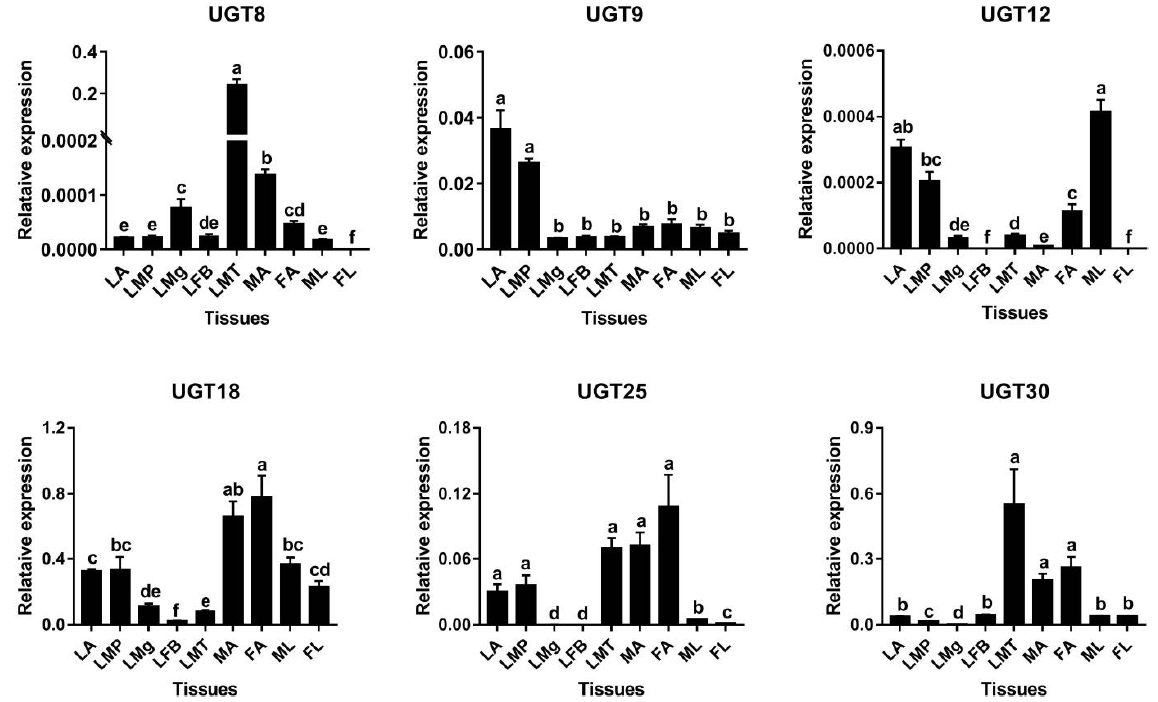
Figure 4. qPCR analysis of six candidate UGT genes in A. yunnanensis . Data denote mean ± standard errors. Different lowercases above bars represent significant differences among tissues (p < 0.05, ANOVA, LSD). LA, larval antennae; LFB, larval fat bodies; LMP, larval maxillary palps; LMg, larval midguts; LMT, larval Malpighian tubules; MA, male antennae; ML, male legs; FA, female antennae; FL, female legs.